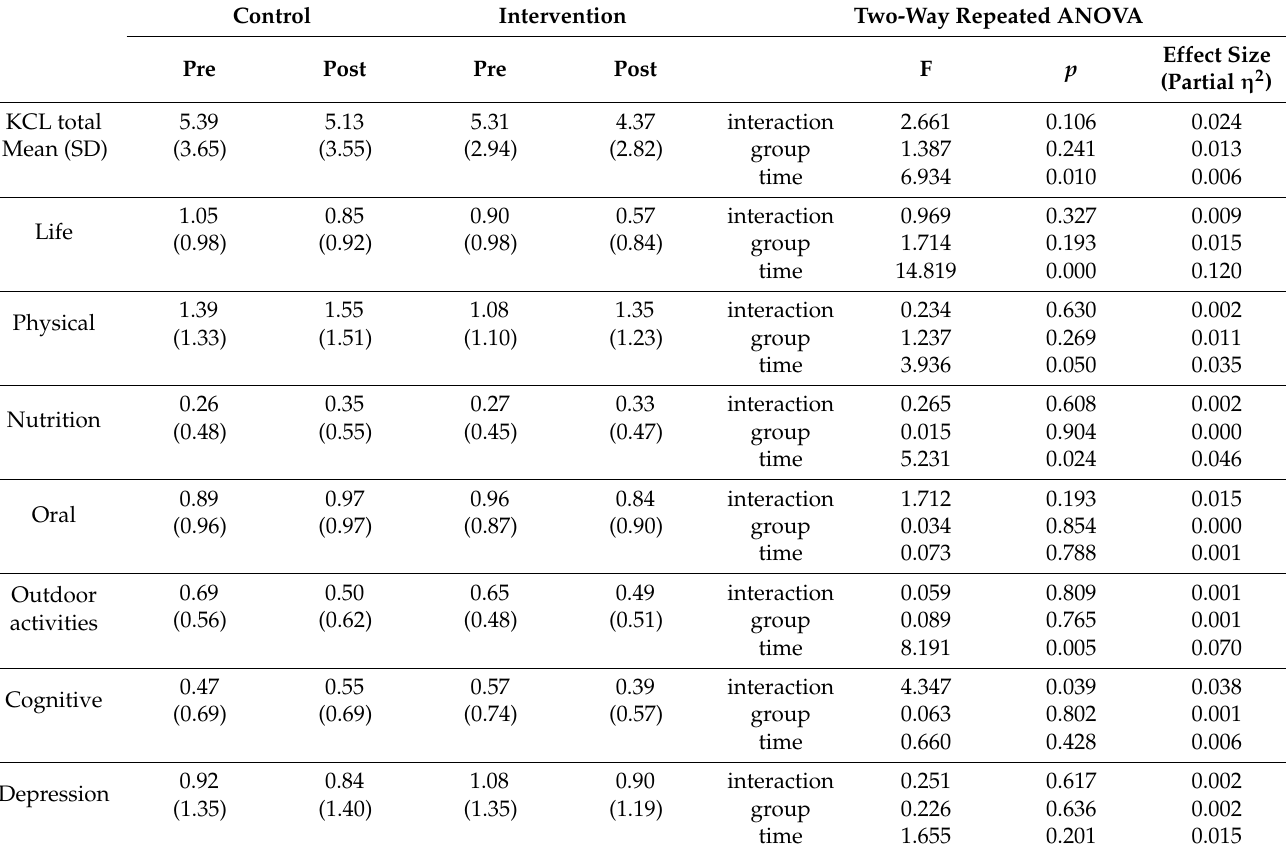
Table 3. Comparison of KCL total score and sub-domain score changes in the two